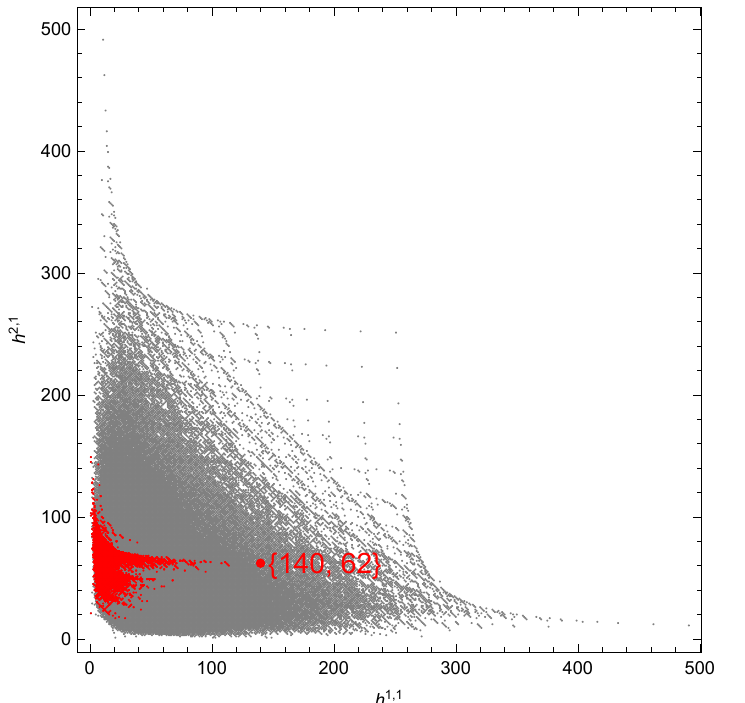
Figure 2 . The Hodge numbers of the Calabi-Yau threefolds associated with 4D re(cid:13)exive polytopes lacking a 2D re(cid:13)exive subpolytope (red), plotted over the Hodge numbers of the full set of toric hypersurface Calabi-Yau threefolds (gray).